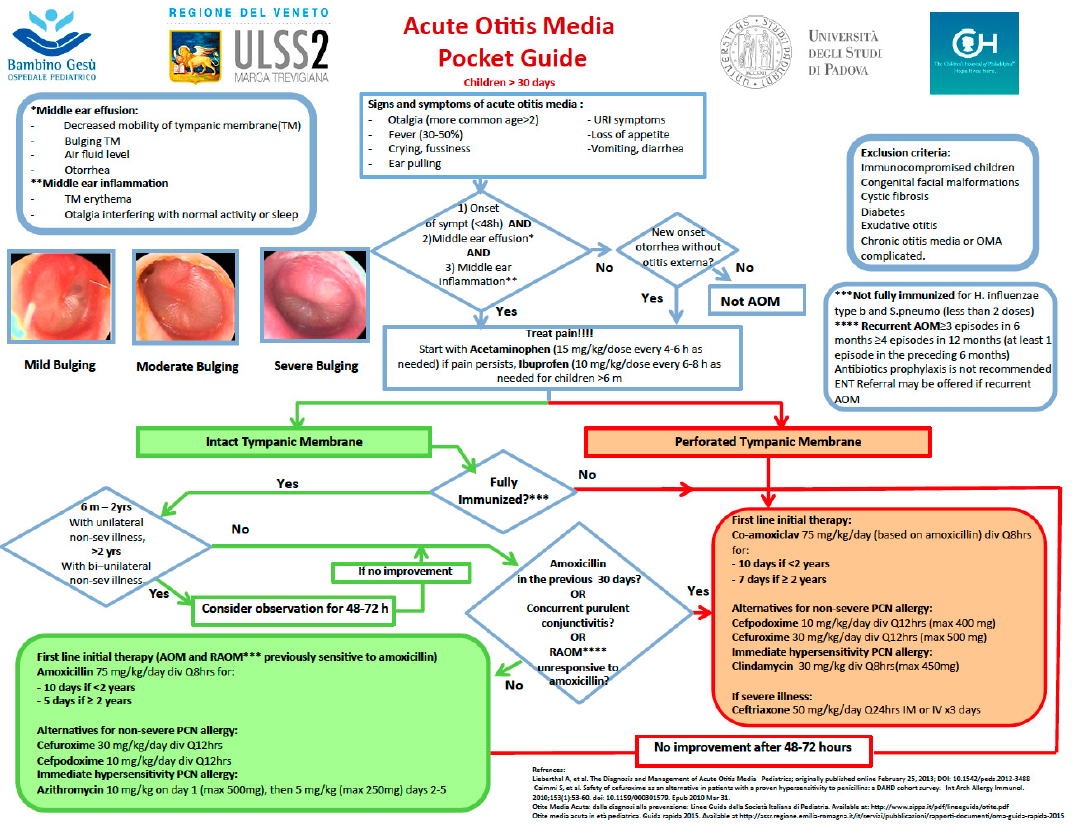
Figure A1. Clinical pathway for acute otitis media for children older than 30 days of age.